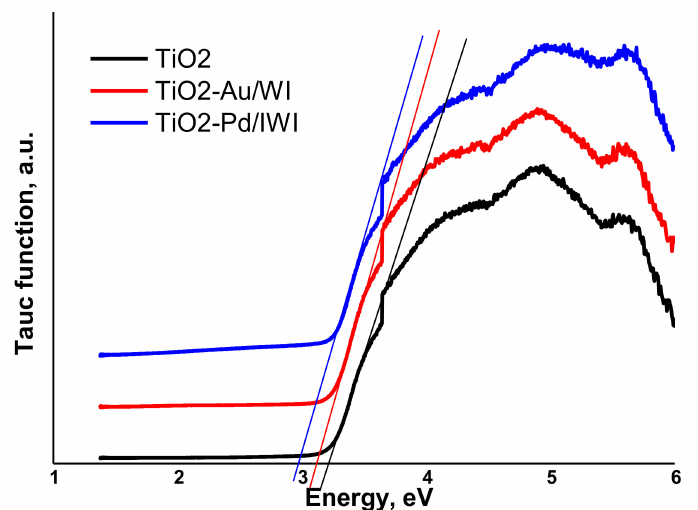
Figure 5. Tauc plots for the TiO 2 -derived samples prepared by the IWI method. The method supposes tracing the graphical dependence between the energy (h × ν ) versus Tauc function ( α × h × υ ) 2 and helps to obtain the value of the band gap by the extrapolation of the linear portion of the curve since it crosses the x -axis; the value in the crossing point gives the band gap energy in